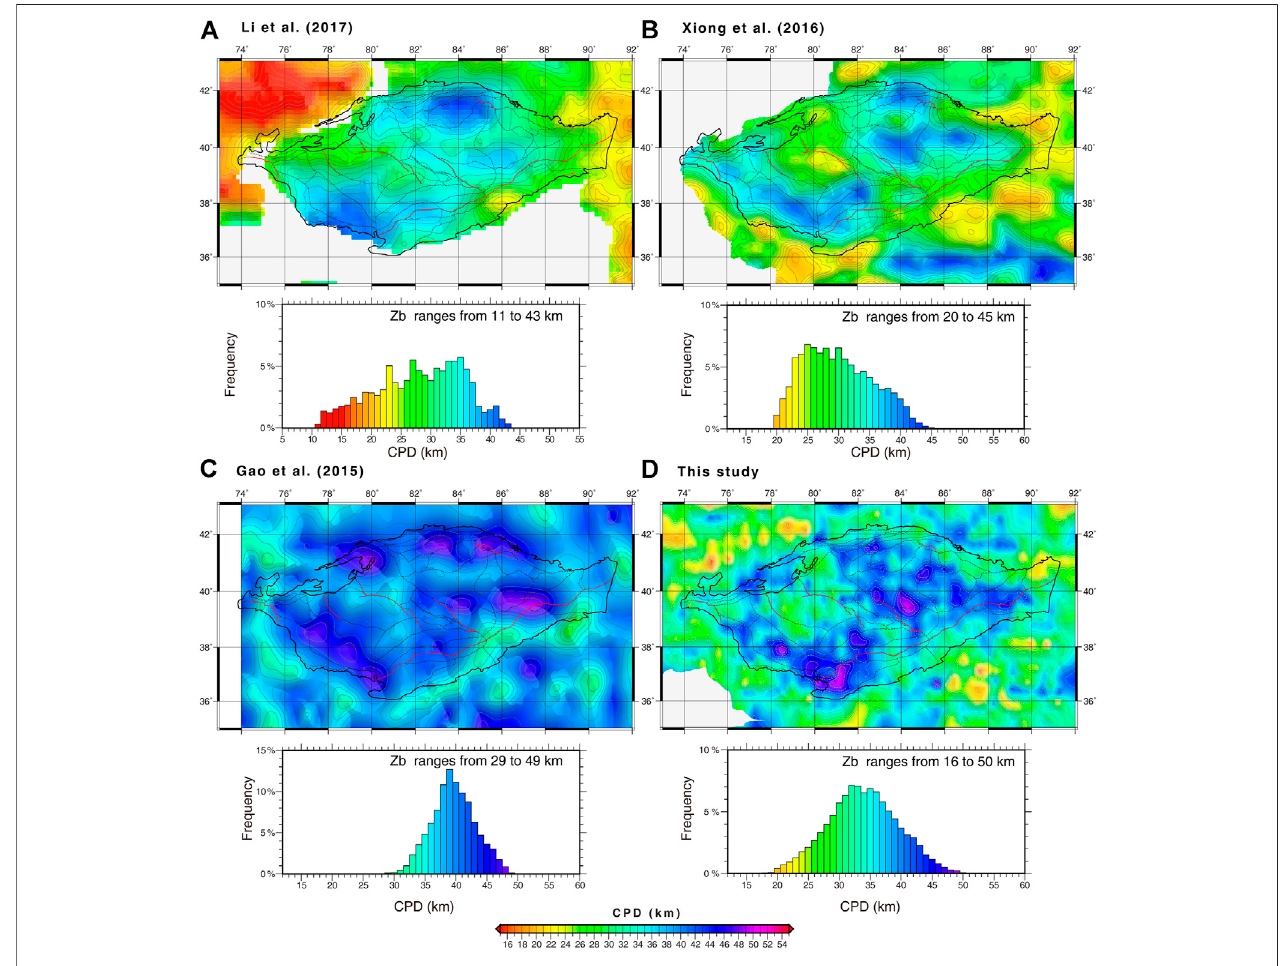
FIGURE5|(A) EstimatedCPDmapofthisstudycomparedtothepreviousmapsfrom (B) Lietal.(2017), (C) Xiongetal.(2016)and (D) Gaoetal.(2015).Thebold and dashed lines represent geologic units as shown in Figure 1 . The histogram of CPD value has been plotted below the corresponding CPD map.